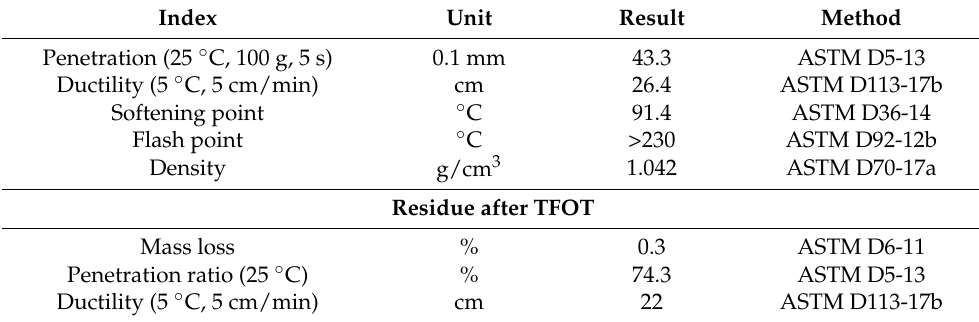
Table 1. Basic performance index test results of the SBS-modified asphalt.